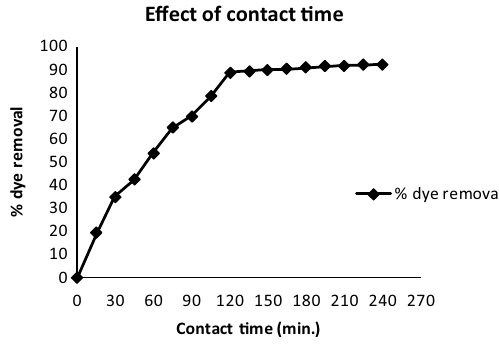
Fig. 12 Effect of contact time on CR dye removal. *Dye con-